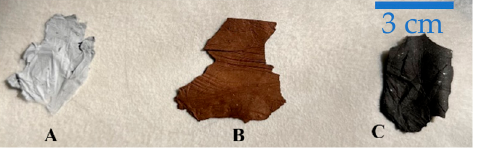
Figure 1. A portion of 10%ZnS–GO/CNF nanofibers after each heat treatment ( A ) post spinning, ( B ) post stabilization, ( C ) post carbonization.